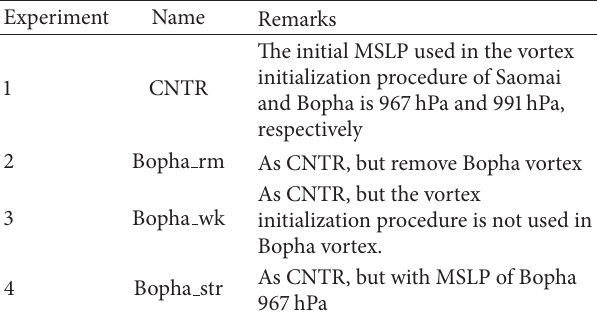
Table 1: List of designed